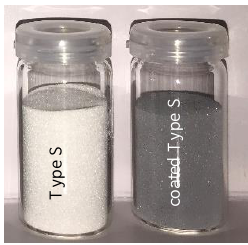
Figure 3. Coating of Type S spheres after a coating time of 240 min: The original spheres have a white color, the Al-coated spheres show a gray coloration.